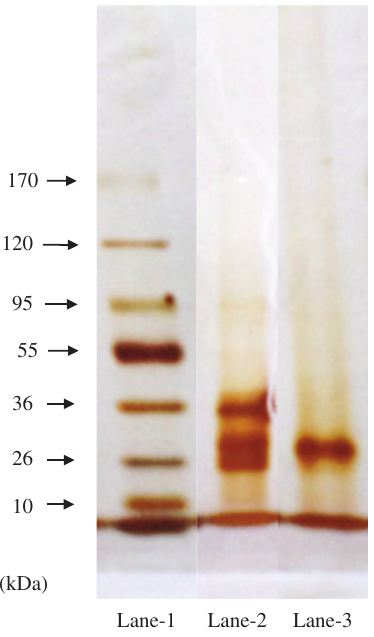
Figure 8: SDS PAGE pattern of peroxidases from orange ( Citrus sinenses )